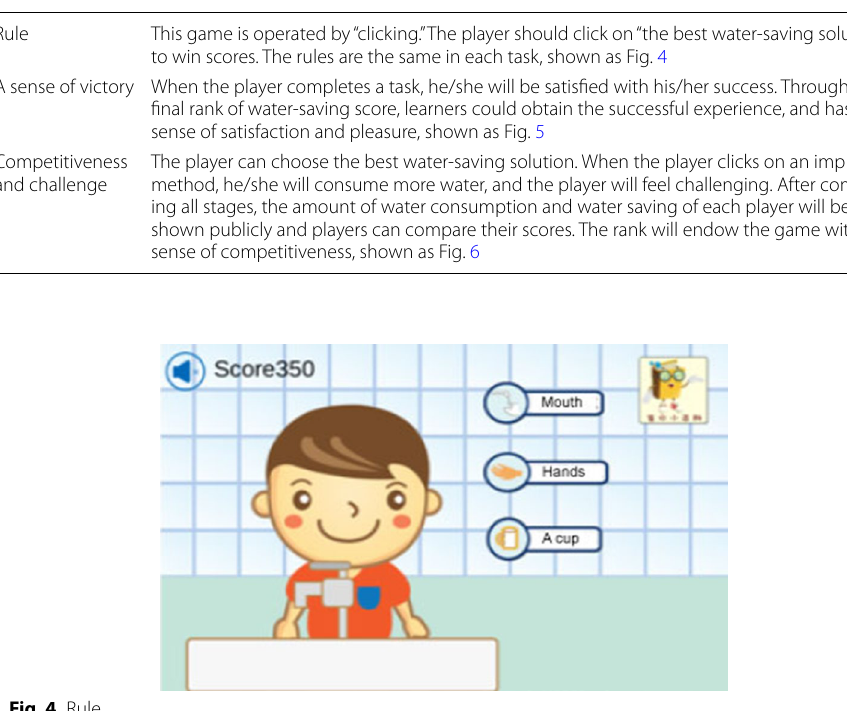
Table 3 Description of the water‑saving game and game elements Element Water-saving game